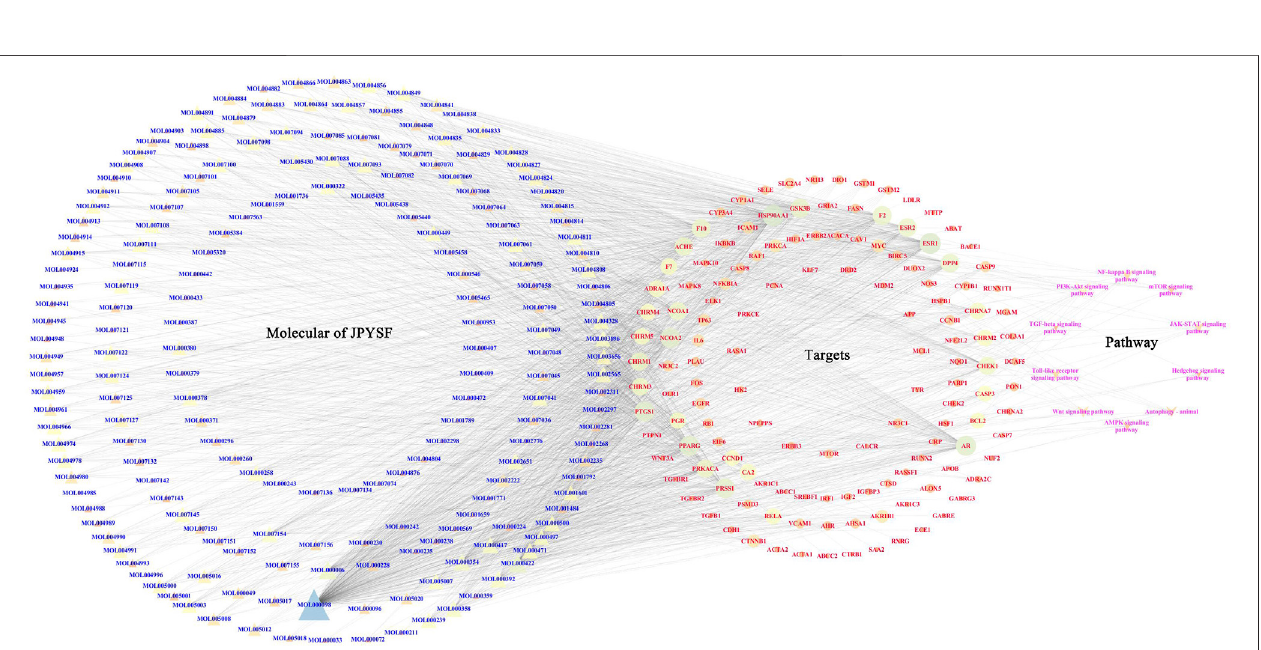
FIGURE4| The “ chemicals-shared targetgenes-signalpathway"(C-T-S)network.ThebluefontsrepresentthecomponentsofJPYSF,theredfontsrepresentthe targets of JPYSF components and epithelial – mesenchymal transition (EMT), and the rose fonts represent the signaling pathway.